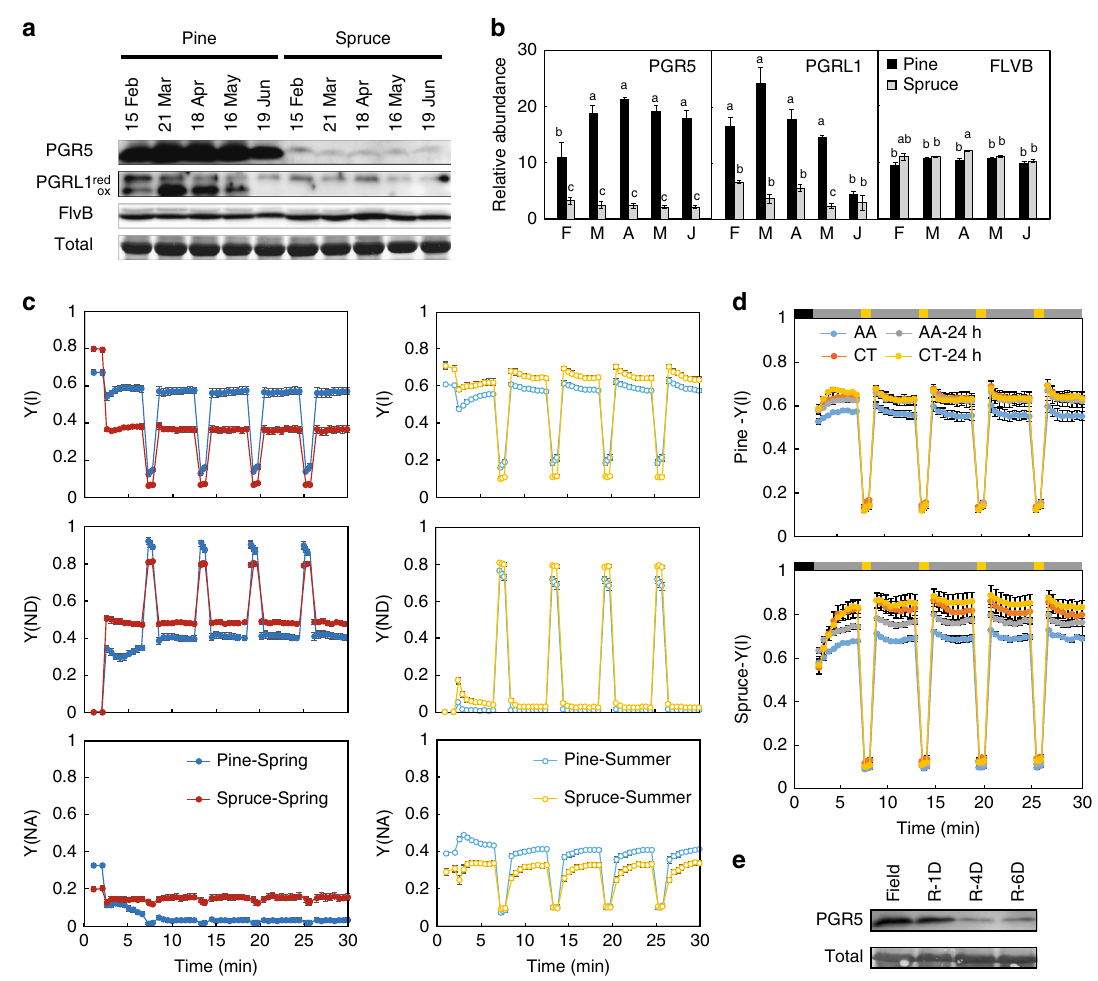
Fig. 5 Contribution of PGR5 to photoprotection in Scots pine and Norway spruce during the critical spring months. a , b Abundance of PGR5, PGRL1, and FLVB. Protein levels were examined by immunoblot analyses with speci fi c antibodies against PGR5, PGRL1, and FLVB. Both reduced (red) and oxidized (ox) forms of PGRL1 protein, were detected in Scots pine, were collected from February to June 2017. Twenty- fi ve μ g of total protein was loaded per lane, and a representative band from the stained gel is shown as a loading control. Protein levels in Scots pine (black) and Norway spruce (gray) were quanti fi ed from three independent experiments using the program ImageJ. Signi fi cant differences were indicated with different letters above the bars (one-way ANOVA, P < 0.05). c PSI redox status comparison between spring and summer. The same protocol applied in Fig. 4 was used for samples of Scots pine (dark blue and light blue) and Norway spruce (red and yellow) collected from the fi eld in April (Spring) and in June (Summer). d Effect of antimycin A (AA) treatment upon light fl uctuations in a controlled recovery experiment. Scots pine and Norway spruce samples collected from the fi eld in April. After the initial measurements, samples were allowed to recover at room temperature for 24 h, and measured again. Needles were treated with water (orange and yellow circles) or 200 μ mol AA (blue and gray circles). The same protocol applied in Fig. 4 was used for the measurements. The parameter Y(I), operating ef fi ciency of PSI is shown. Each data point represents the mean of four biological replicates (mean ± SE, n = 4). e Scots pine samples collected from the fi eld in April and recovered at room temperature for 1 (R-1D), 4 (R-4D), and 6 days (R-6D) were used for determining abundance of PGR5. Representative bands from the ponceau-S stained membranes are shown as loading